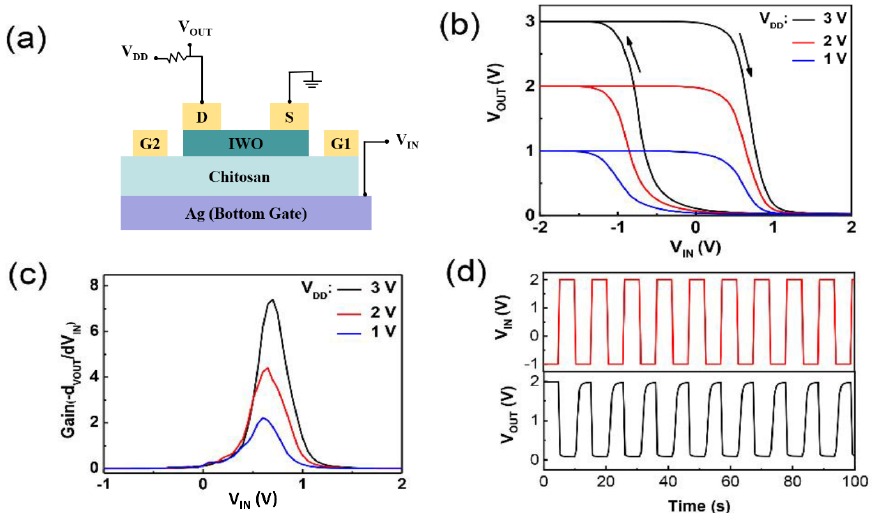
Figure 3. ( a ) Schematic illustration of resistor-loading inverter based on a flexible IWO-based TFT; ( b ) Voltage transfer characteristic curves; ( c ) Voltage gain characteristic curves; ( d ) Dynamic response behavior curves of the inverter.